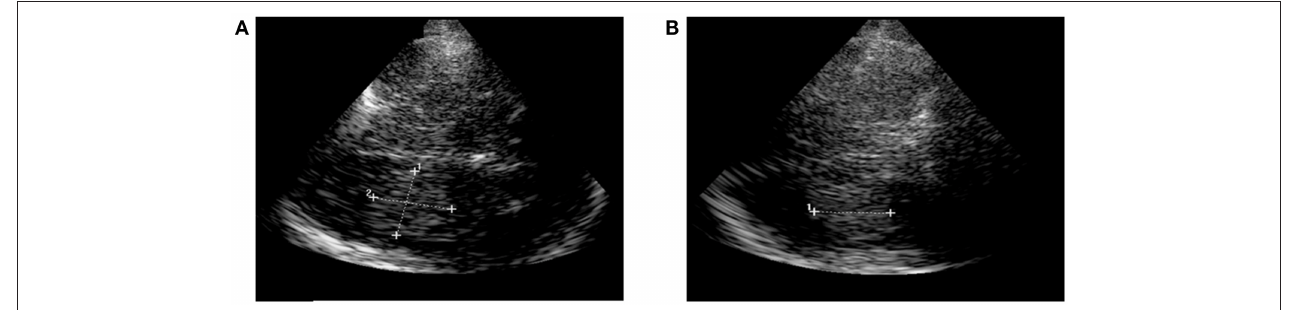
FIGURE 1 | Sonographic ICH-volumetry. (A) Hemorrhage expansion measured in the axial plane (length and width of the ICH). (B) Hemorhage expansion measured in the coronal plane (height of the ICH). ICH, intracerebral hemorrhage.